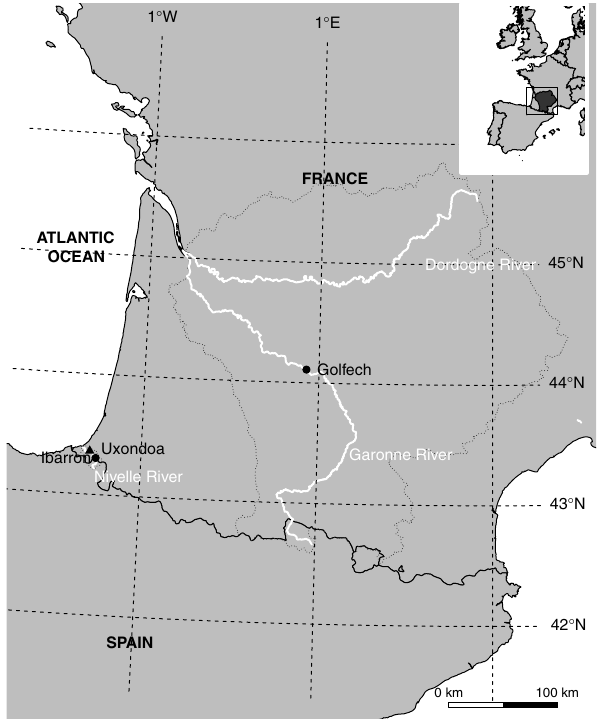
Fig. 1. Location of the study site. Spawners were collected at the Ux- ondoa fish trap (black triangle) on the Nivelle River. Temperatures were monitored at Ibarron, on the Nivelle River and at the Golfech dam, on the Garonne River (black